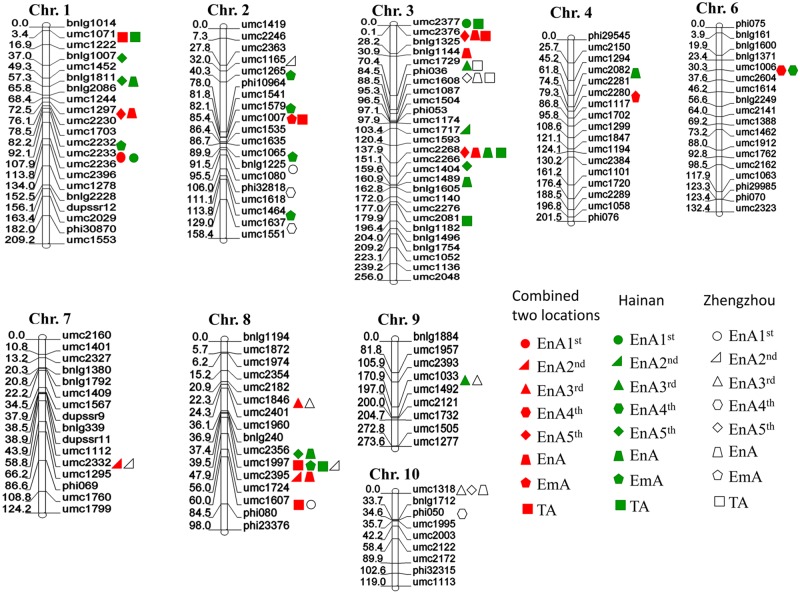
Distribution of QTL for kernel abortion related during parthenogenesis induced process in the second population (Zheng58×K22).The circle means QTLs for the 1st endosperm abortion kernels (EnA1st); the right triangle means QTLs for the 2nd endosperm aborted kernels (EnA2nd), the equilateral triangle means QTLs for the 3rd Endosperm aborted kernels (EnA3rd), the hexagon means QTLs for the 4th endosperm aborted kernels (EnA4th), The rhombus means QTLs for the 5th endosperm aborted kernels (EnA5th), the trapezoid means QTLs for the total endosperm aborted kernels (EnA). The pentagon means QTLs for the embryo abortion kernels (EmA). The square means QTLs for the total aborted kernels (TA). The red means the QTL identified across two environments, the green means the QTL identified in Hainan environment; the white means the QTL identified in Zhengzhou environment.